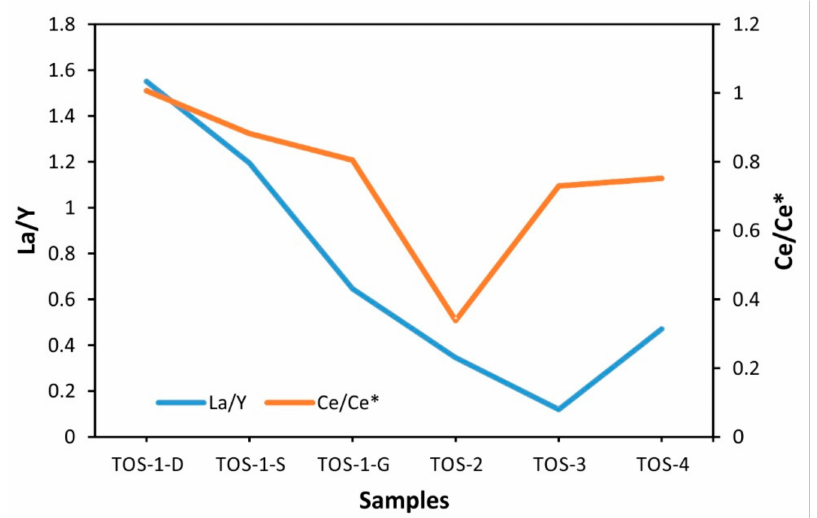
Figure 5. La/Y ratio and Ce anomaly variability expressed as Ce/Ce* in the bauxite samples of the Toši´ci-Duji´ci deposit.